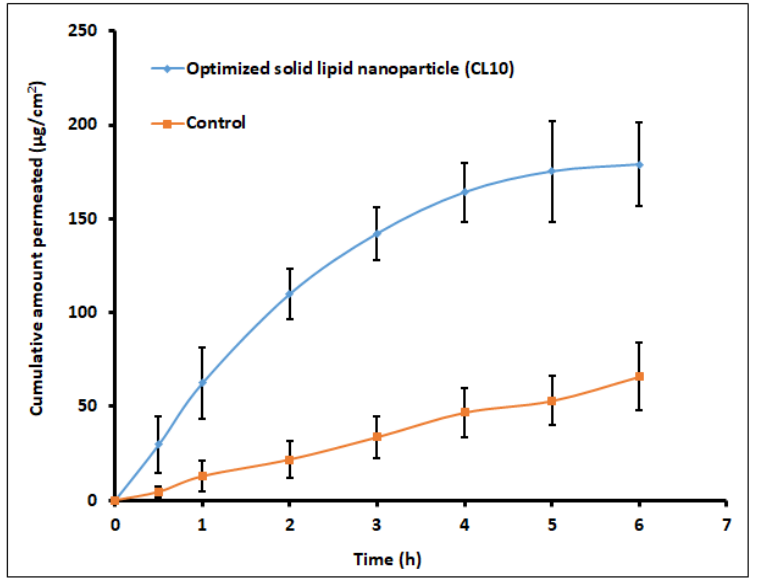
Figure 4. The total amount of clarithromycin that passed through the goat cornea as a result of the optimized solid lipid nanoparticles formulation and the control (solution) constituted an equivalent dose (adapted from [1], published by MDPI, 2021).